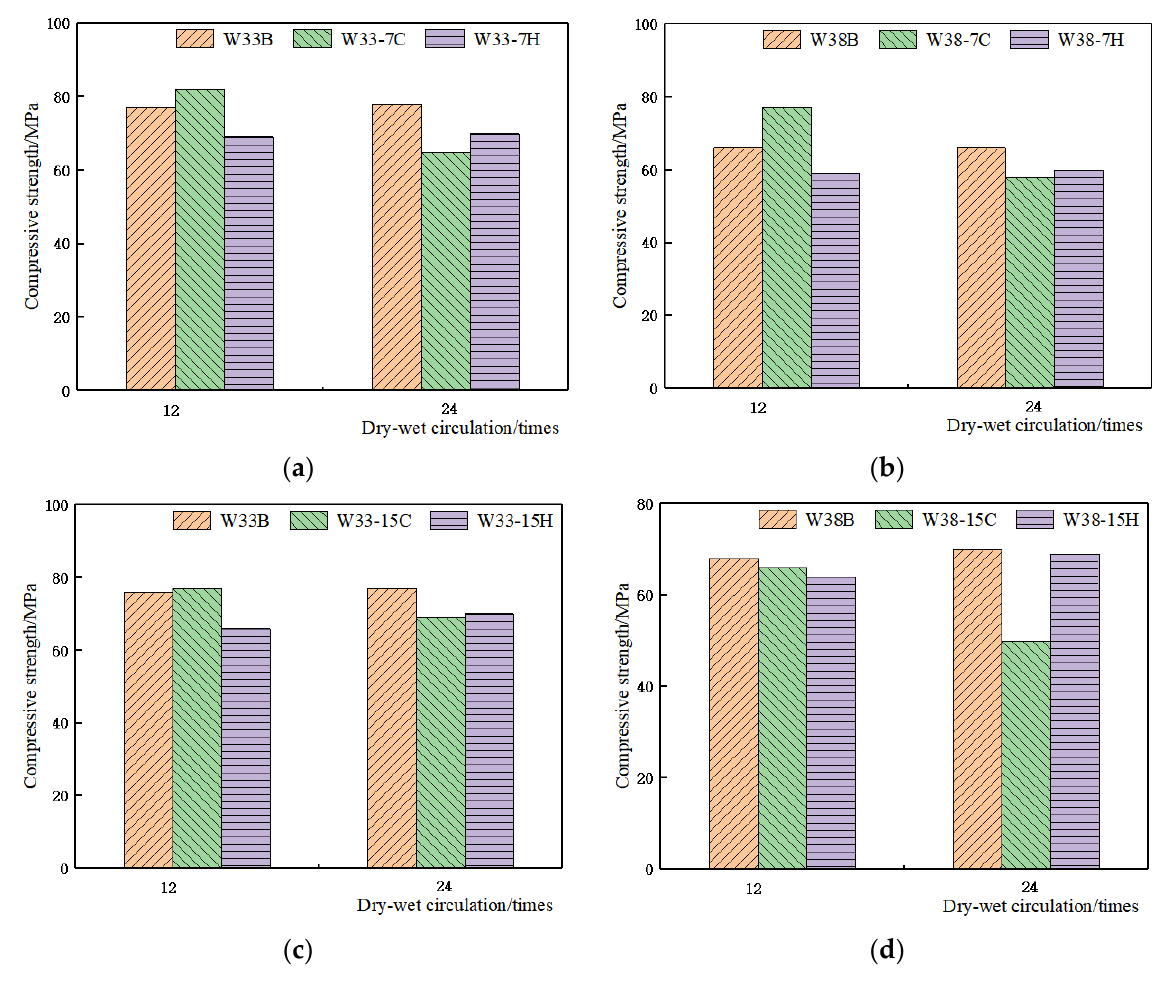
Figure 3. Change in compressive strength in different test conditions: ( a ) W/C ratio of 0.33 in concentration of 7000 mg/L; ( b ) W/C ratio of 0.38 in concentration of 7000 mg/L; ( c ) W/C ratio of 0.33 in concentration of 15,000 mg/L; ( d ) W/C ratio of 0.38 in concentration of 15,000 mg/L.